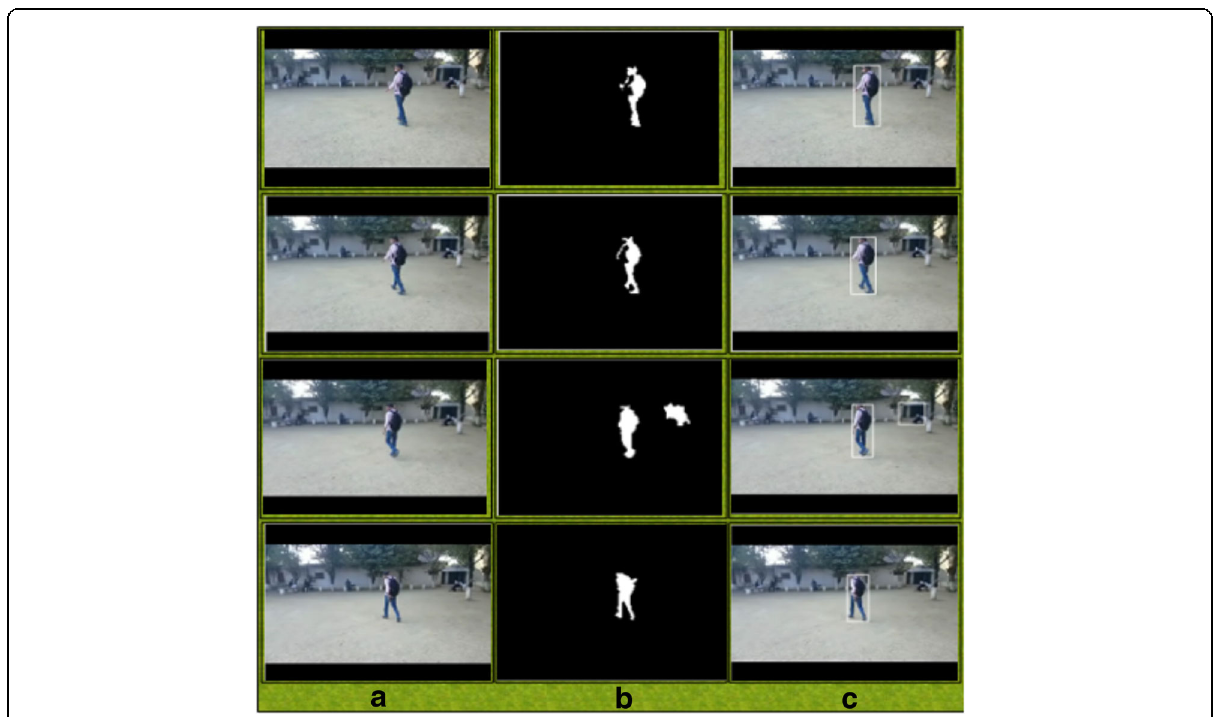
Fig. 6 Segmentation results of own recorded